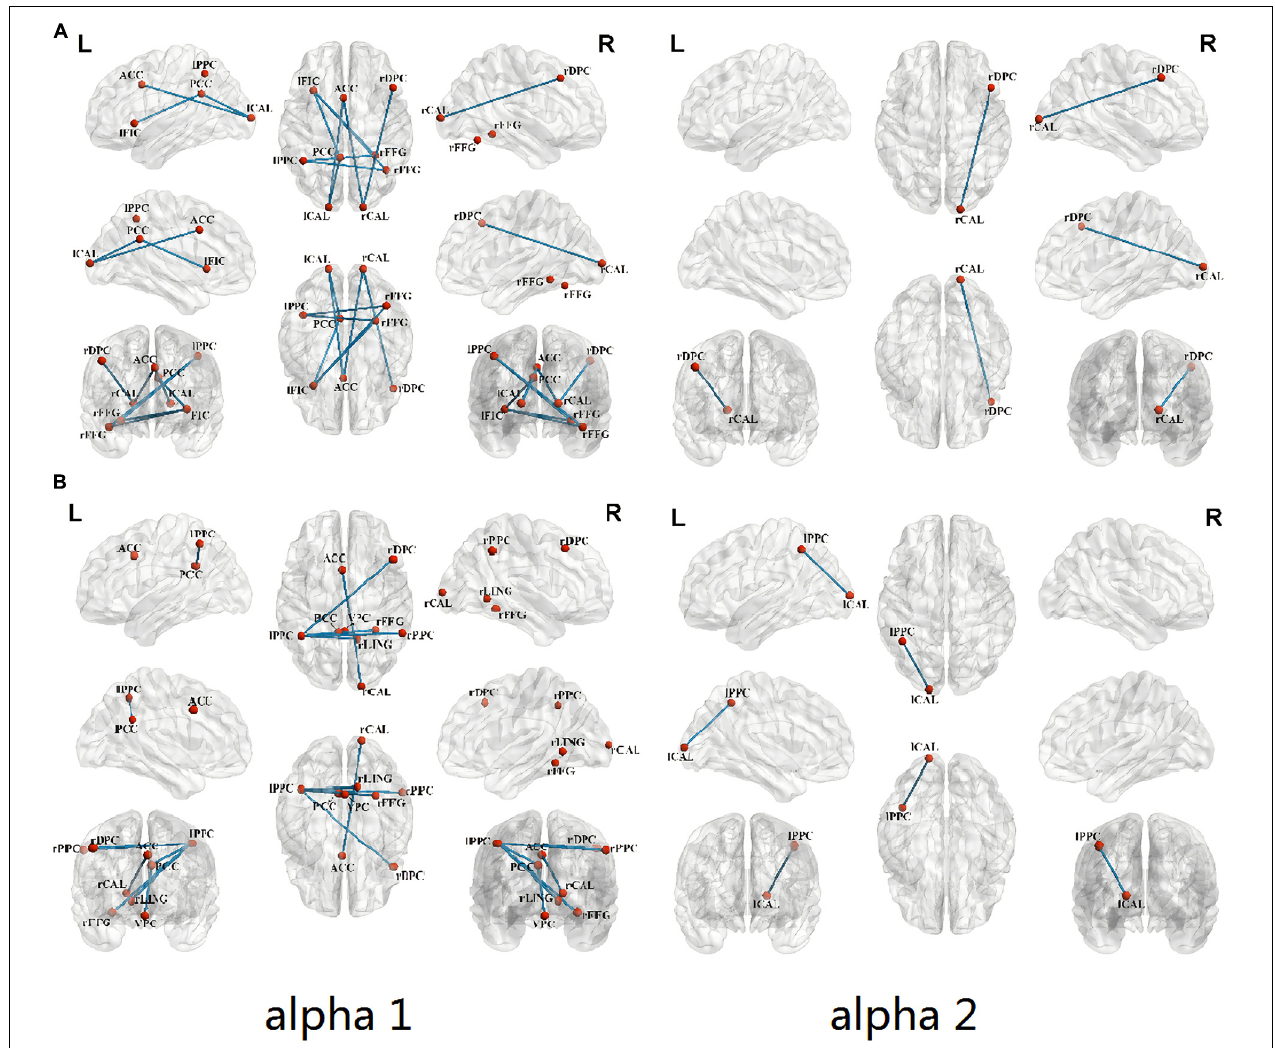
FIGURE 3 | Comparison of FC between ROIs in children with congenital cataracts when compared with healthy controls ( p < 0.05). (A) Compared with healthy controls, the congenital cataracts group showed a weak lagged coherence for alpha frequency between ROIs. (B) Significantly decreased lagged phase synchronization in congenital cataract patients in contrast to healthy